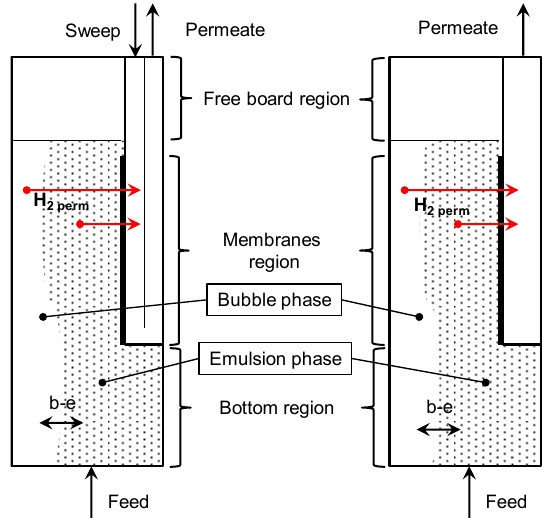
Figure A1. Scheme of fluidized bed membrane reactor developed in ACM for vacuum pump and sweep gas case.